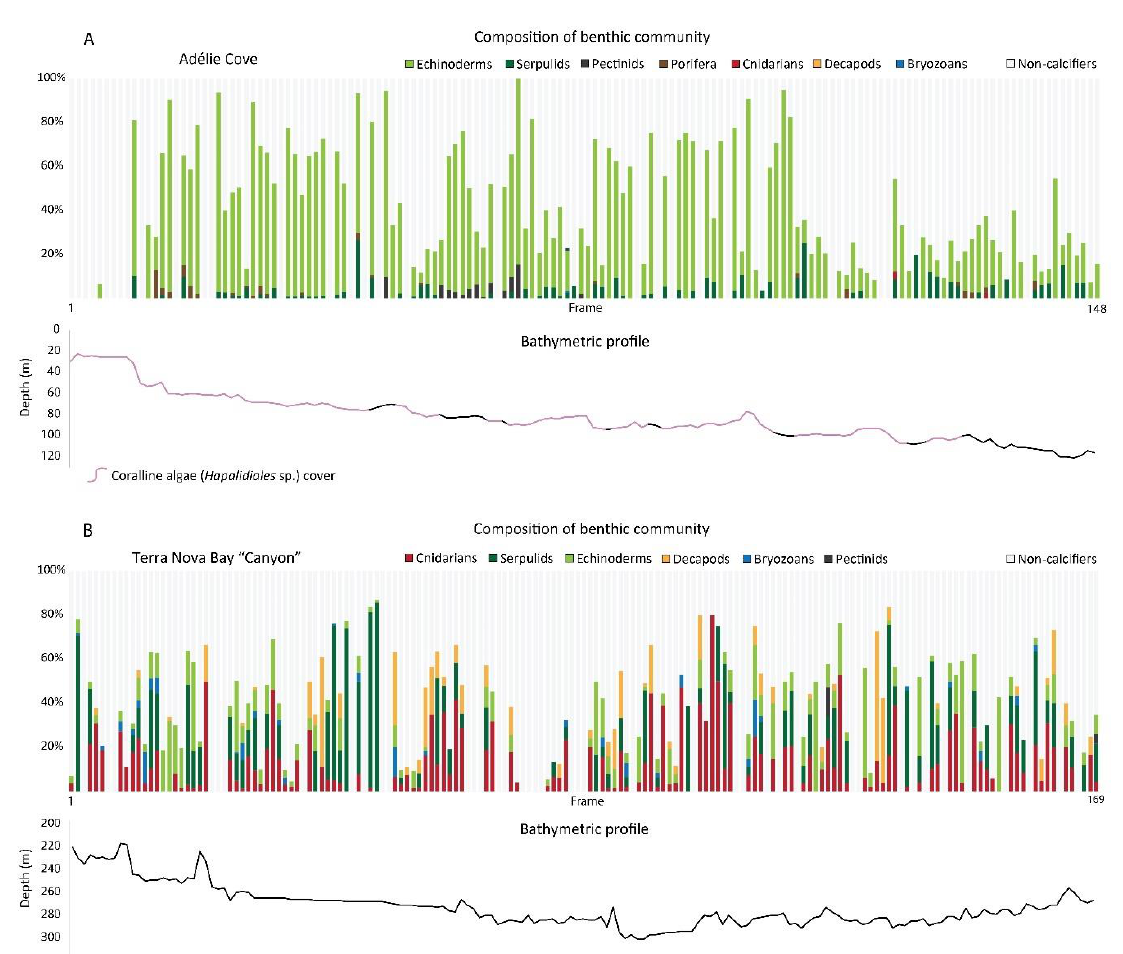
Figure 5. Composition of biological assemblages and depth profile of the visual surveys. Percentage composition of benthic community (bars) and depth (lines) of frames extracted from video recordings performed in the Adélie Cove ( A ) and the Terra Nova Bay Canyon ( B ). Colors refer to the different calcifiers groups. “Decapods” class represents an abundance of Chorismus antarcticus and Notocrangon antarcticus . Black lines refer to bathymetric profile of frames. In A, colored depth profile segments represent portions of seafloor characterized by coralline algae (Hapalidiales spp.) covering.